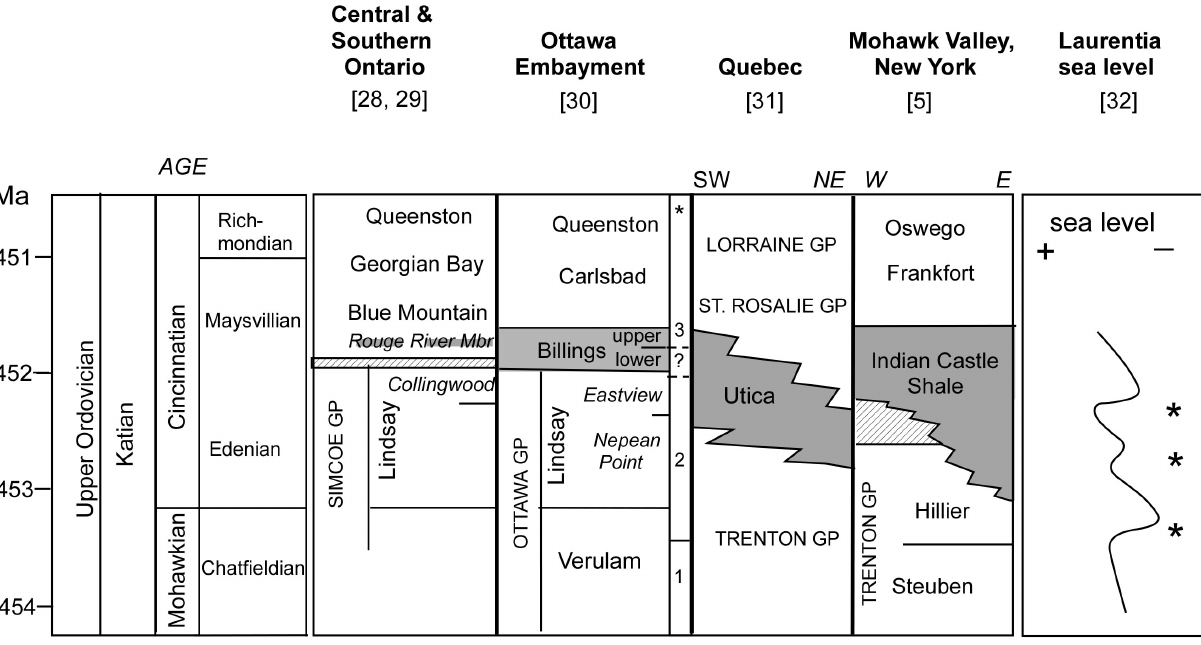
Figure 3. Upper Ordovician stratigraphy of the Ottawa Embayment and adjacent regions [28–31] shown relative to North American sea level curve [32], with large astrices illustrating periods of sea level highstands in the Baltoscandia record [32]. Existing and proposed stratigraphic members of the Lindsay Formation are